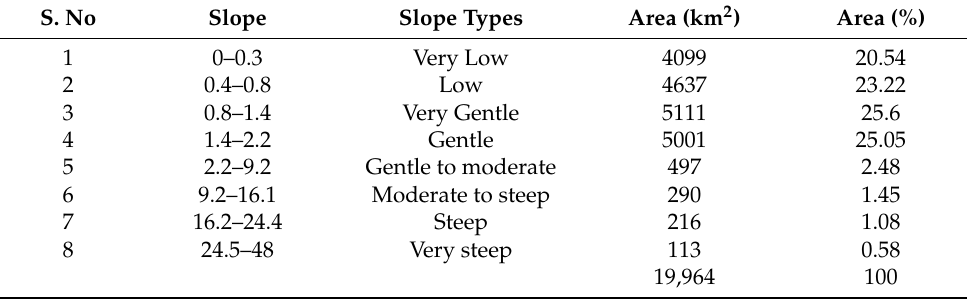
Table 5. Slope area statics of study area and its classification.